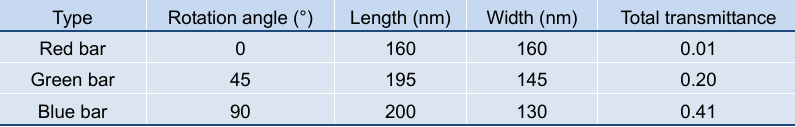
Table 1 | Parameters and simulated modulation effect of three kinds of